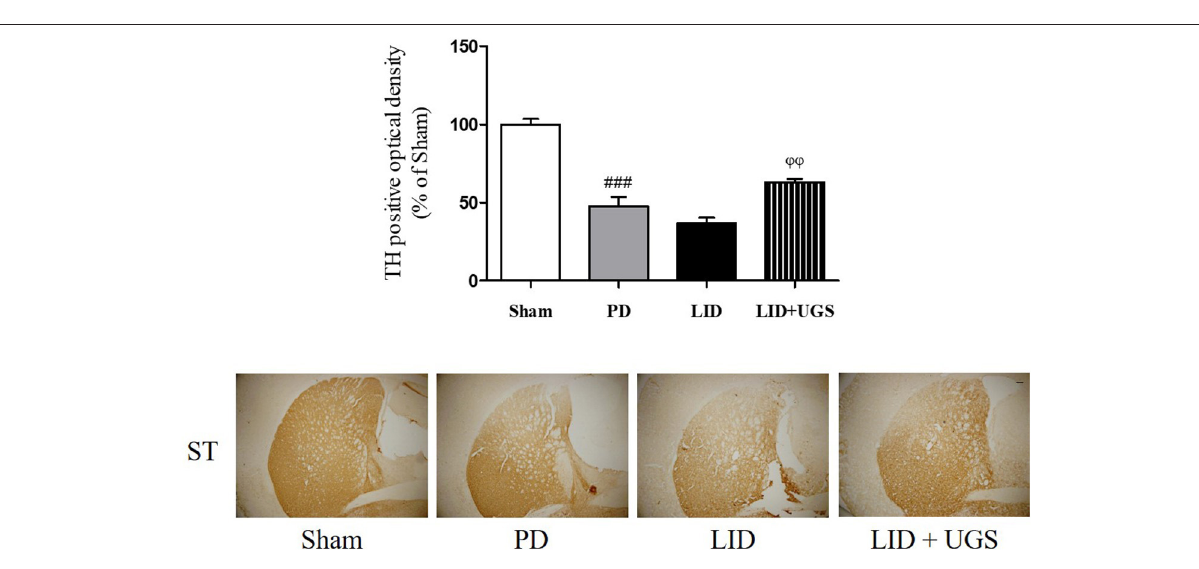
motor learning. The subsequent long-lasting overexpression of 1 FosB and c-fos induced by p-ERK may also mediate long-term potentiation in the dopamine-depleted ST (Pavon et al.,